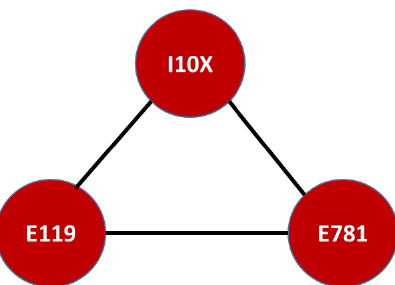
Figure 12. Highest overlapping cliques in morbidity and mortality for SISBEN I and II. Mortality